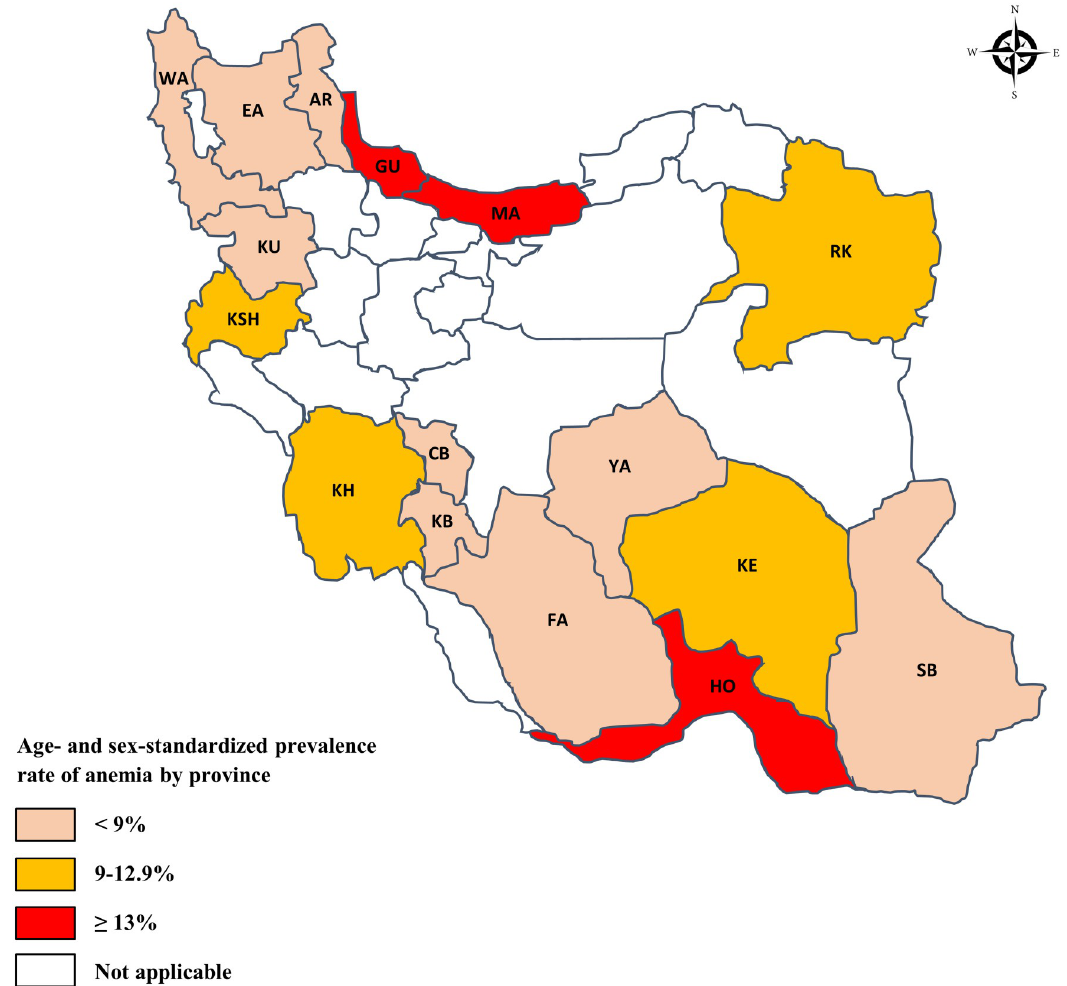
Fig 1. Graphical presentation of age- and sex-standardized prevalence of anemia in study provinces, including Ardabil (AR), Chaharmahal and Bakhtiari (CB), East Azerbaijan (EA), Fars (FA), Guilan (GU), Hormozgan (HO), Kerman (KE), Kermanshah (KSH), Khouzestan (KH), Kohgiluyeh and Boyer-Ahmad (KB), Kurdistan (KU), Mazandaran (MA), Razavi Khorasan (RK), Sistan and Balouchestan (SB), West Azerbaijan (WA), and Yazd (YA).